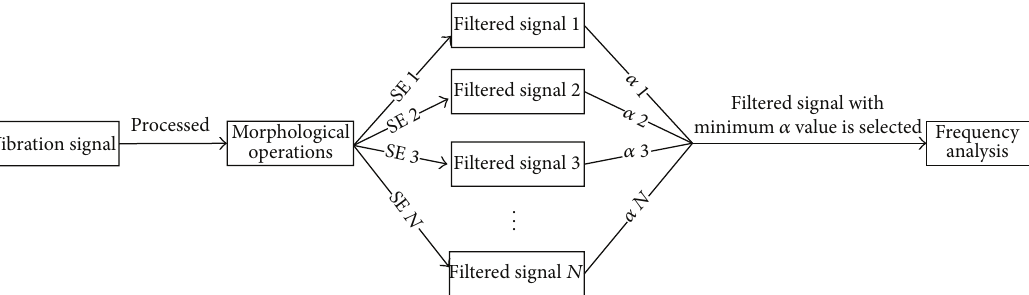
Figure 12: Framework of proposed diagnosis method based on stable distribution and morphological gradient filter.